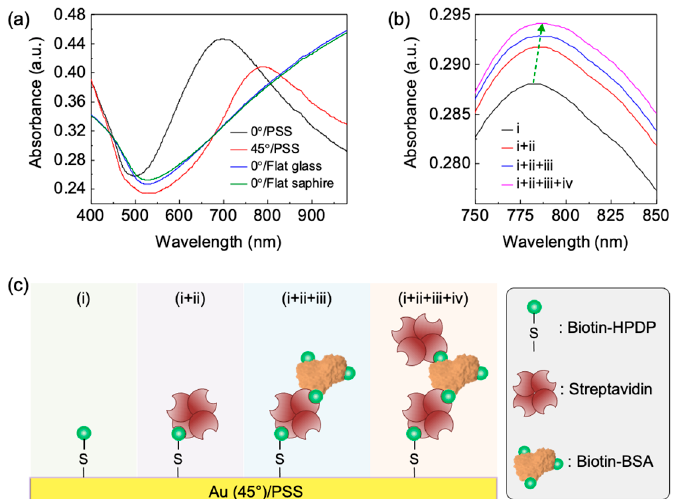
Figure 3. ( a ) Absorbance of obliquely and vertically deposited Au on PSSs, and vertically deposited Au on flat glass and sapphire substrates. ( b ) LSPR shift of the PSS with obliquely deposited Au: (i) biotin-HPDP, (ii) STA, (iii) biotin-BSA, and (iv) STA. ( c ) Schematic illustration for step-by-step biomolecule detection using an Au/PSS. The stages of (i), (i + ii), (i + ii + iii), and (i + ii + iii + iv) correspond to those in Figure 3b.